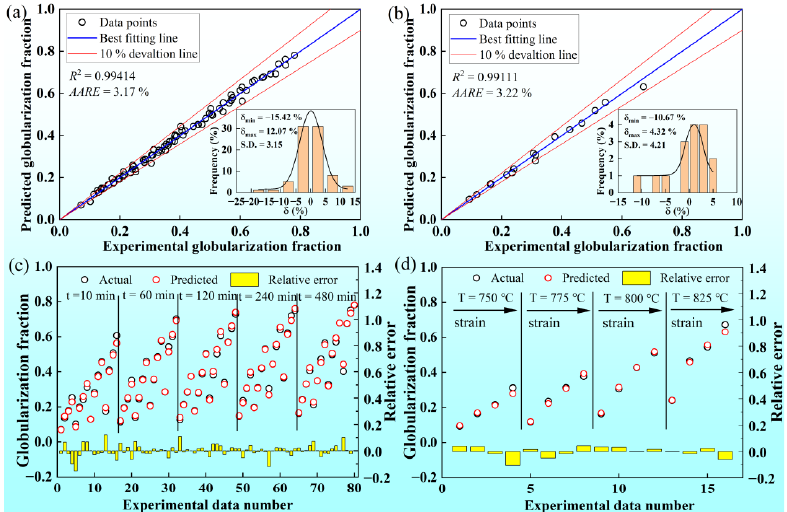
Figure 12. ( a ) Correlation and error analysis of the training set; ( b ) correlation and error analysis of the validation set; the relative errors of ( c ) the training set and ( d ) the validation set.